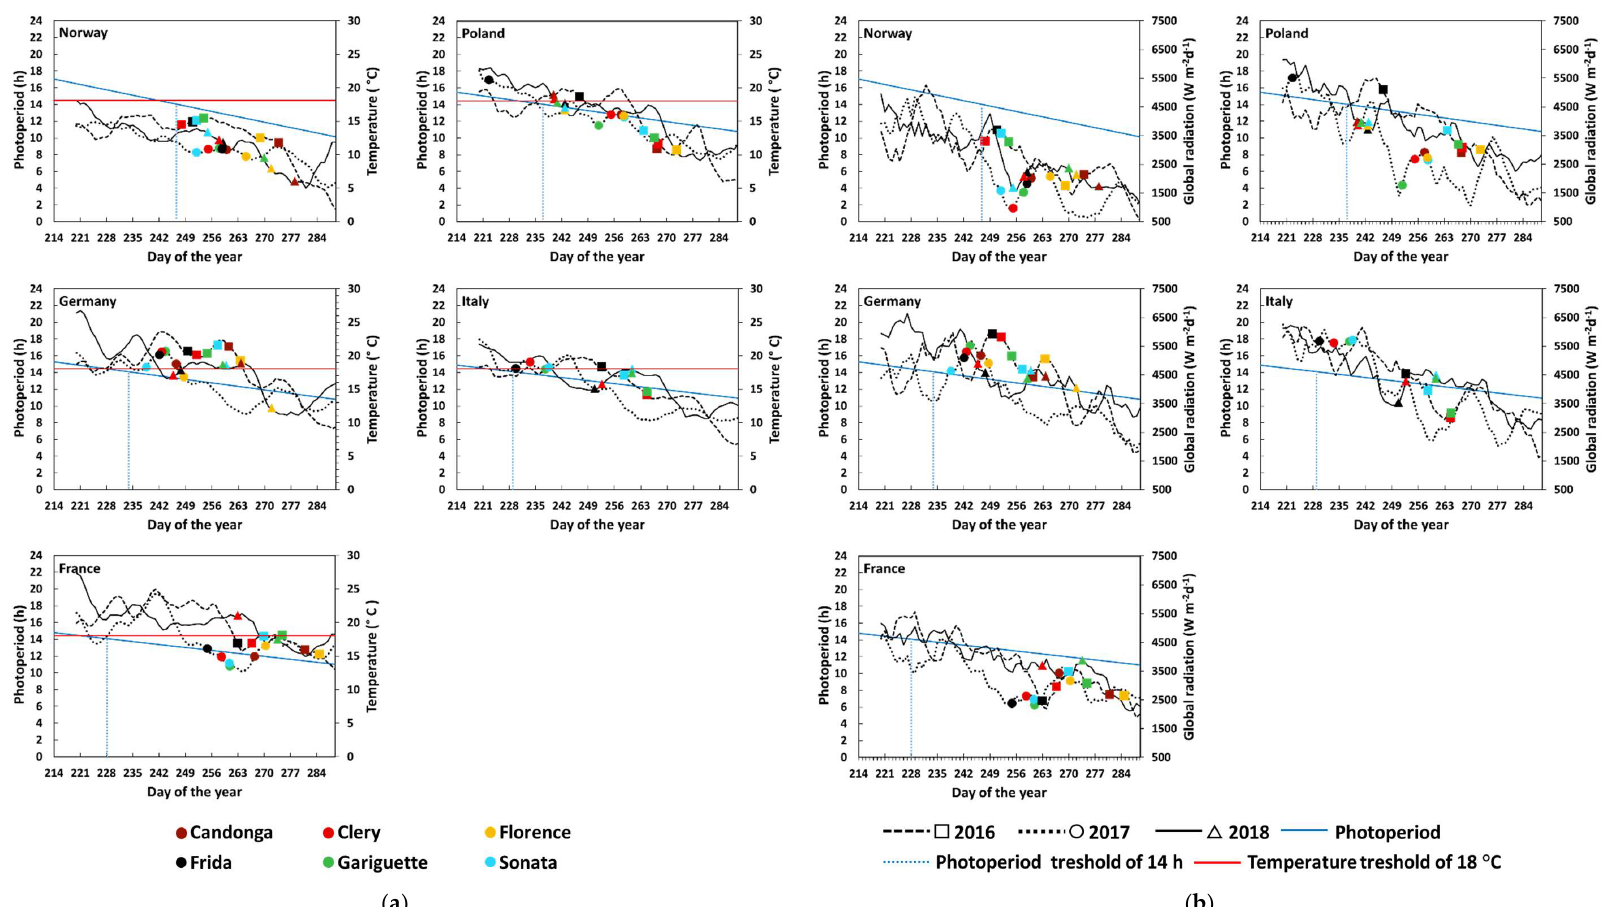
Figure 1. Day of flower initiation (floral developmental Stage 2) of six cultivars grown at five locations in Europe as influenced by ( a ) photoperiod, temperature, and ( b ) photoperiod and global radiation during the 3 years of study. The data are presented as a running average of 7 days.